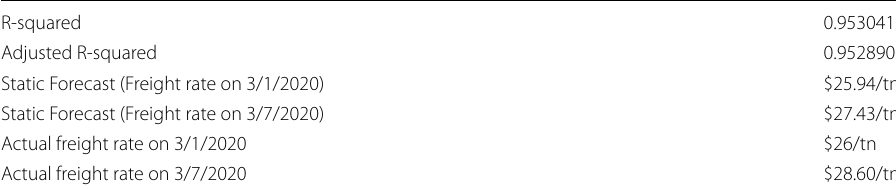
Table 4 Tubarao–China ores. Source : Elaboration by the authors